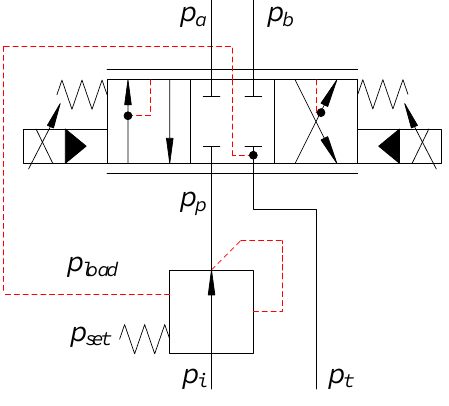
Figure 11. Hydraulic pressure compensated directional control valve for the knuckle